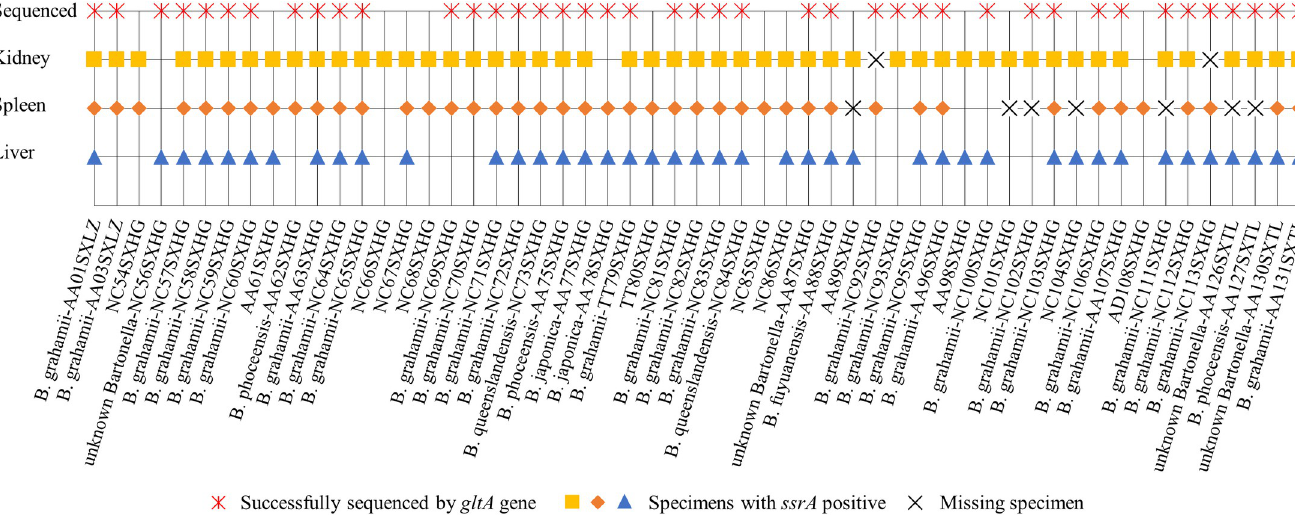
Fig 3. Detection of Bartonella species in various tissues of naturally infected rodents.